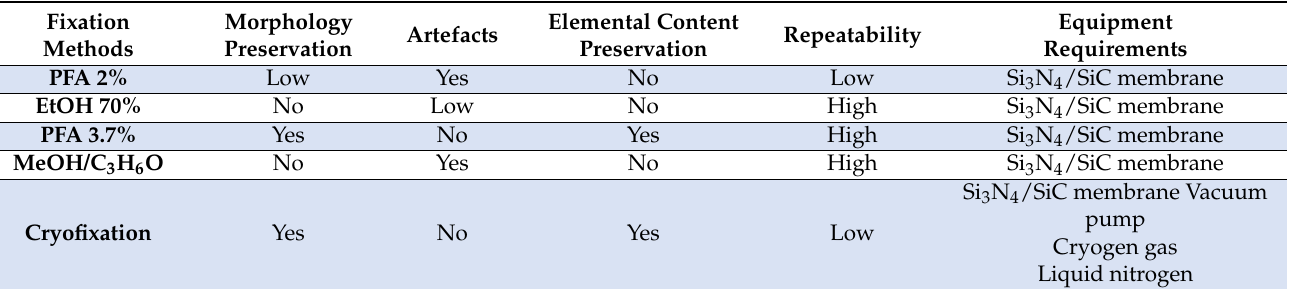
Table 1. Summary of the main analytical constraints of the fixation methods under study for syn- chrotron X-ray